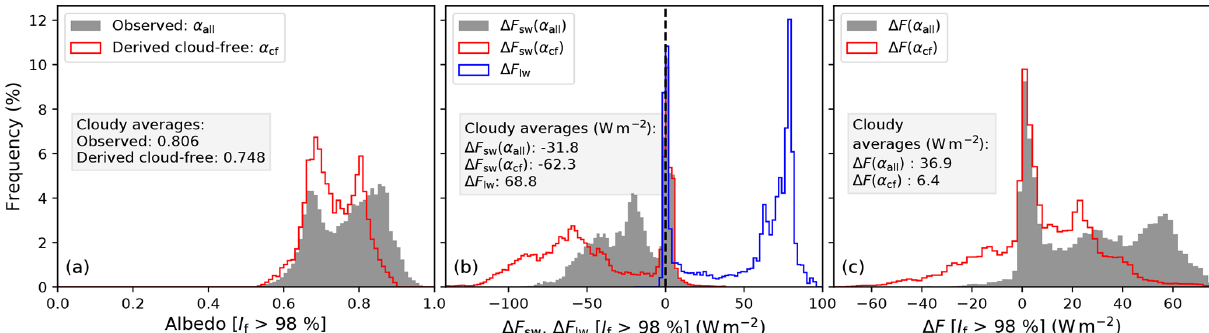
Figure 10. (a) Frequency distribution of the observed ( α all , gray) and cloud-free estimated ( α cf , red) surface albedo for all ACLOUD mea- surements obtained over homogeneous sea ice ( I f > 98%). (b) Terrestrial (blue) and shortwave CRF using the observed albedo ( (cid:49)F sw (α all ) , gray) and the shortwave CRF by applying the estimated cloud-free albedo ( (cid:49)F sw (α cf ) , red). (c) The total (shortwave + longwave) CRF cal- culated with both albedo parameters is shown in panel (c) . Average values for cloudy conditions (LWP > 1gm − 2 ) are given in the embedded text boxes of each